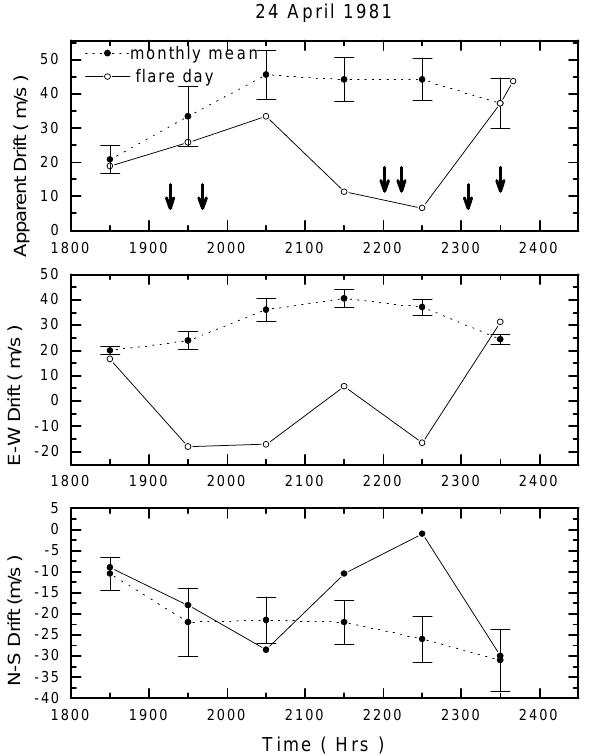
Fig. 1. Variation of Apparent Drift Speed, its E–W and N–S compo- nents on 24 April 1981, along with their respective monthly mean variation. Solid circles connected by dotted lines represent the monthly mean variation. Open circles connected by solid lines rep- resent the speeds on the flare day. Downward pointing arrows from the same ordinate level represent the time of onset, maximum in- tensity and end of a flare. Solar flares occurred at 19:16, 19:41 and 23:05 (2B) and 22:01, 22:14 and 23:30 (1B).